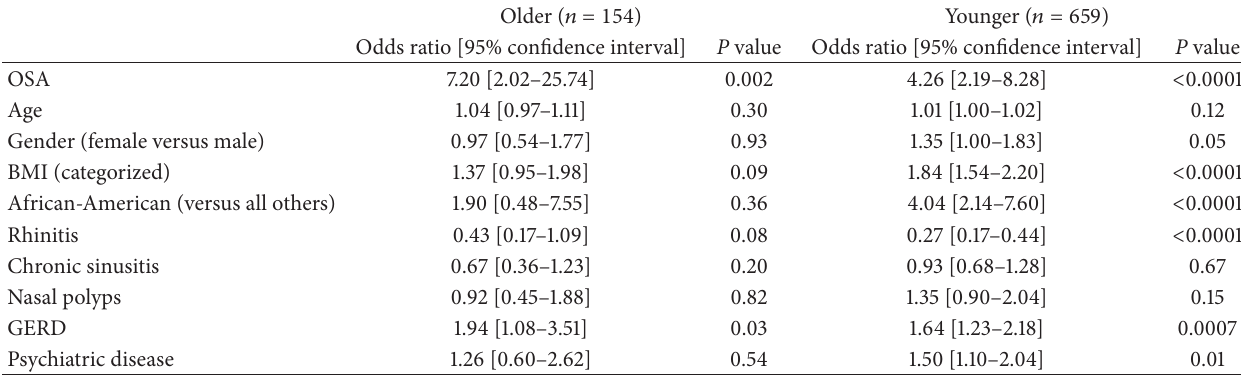
Table 5: Univariate associations of severe asthma (step 3 or 4) with OSA (clinically-diagnosed and untreated) and other traditional factors of asthma control, in the older and younger asthma